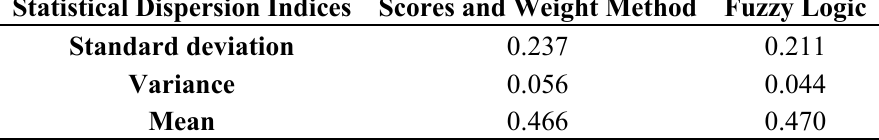
Figure 18. Comparison of the results obtained with both the tested models. Table 5. Statistical dispersion indices for the comparison between the fuzzy logic method and the scores and weight